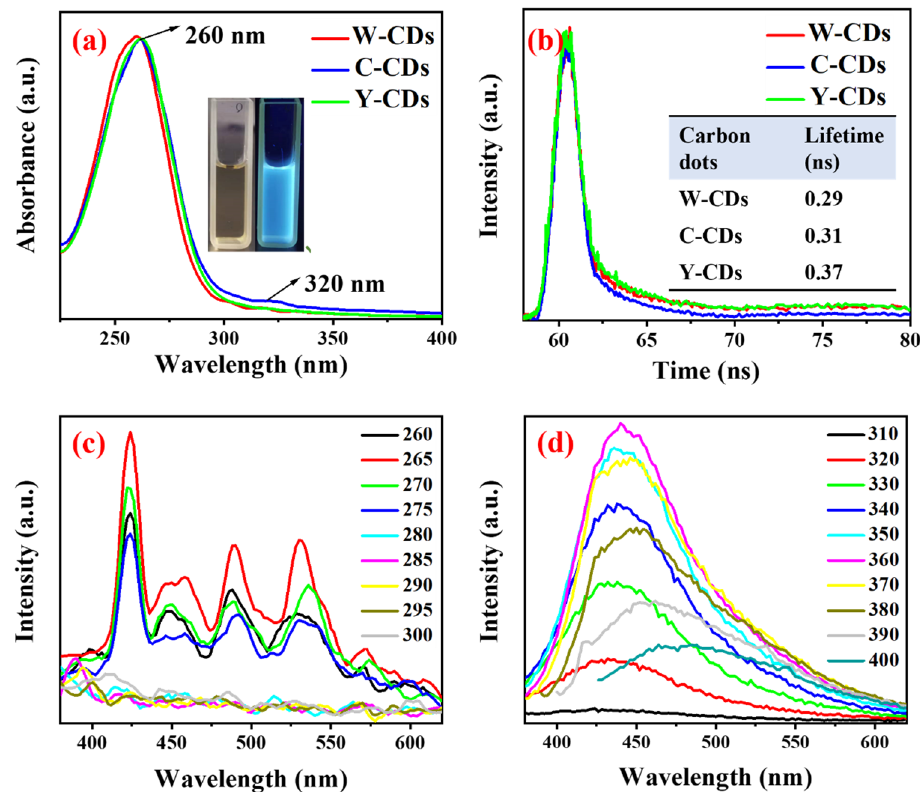
Figure 5. UV absorption spectra of the As-prepared CDs and fluorescence image of the C-CDs in visible light and at 365 nm UV light in upper right illustration ( a ); time-resolved photoluminescent measurements of the synthesized CDs ( b ); fluorescence spectra of the synthesized C-CDs at different excitation wavelengths from 260 to 300 nm ( c ) and from 310 to 400 nm ( d ).